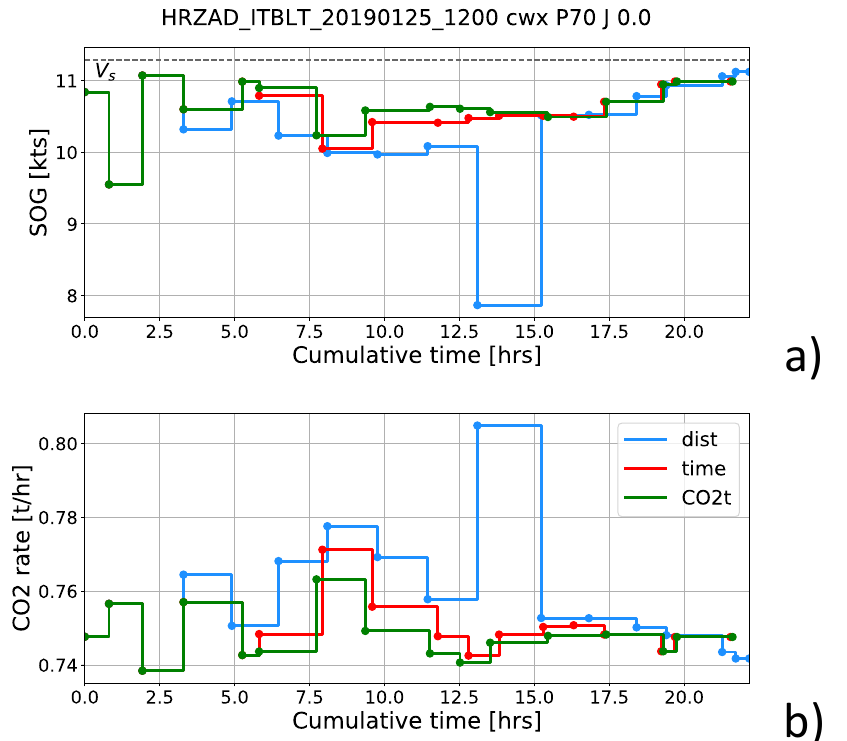
Figure 4. Profile of ( a : SOG; b : dCO 2 /dt) along the three optimal routes of Figure 3 vs. cumulative time since departure, with optimization objectives as in